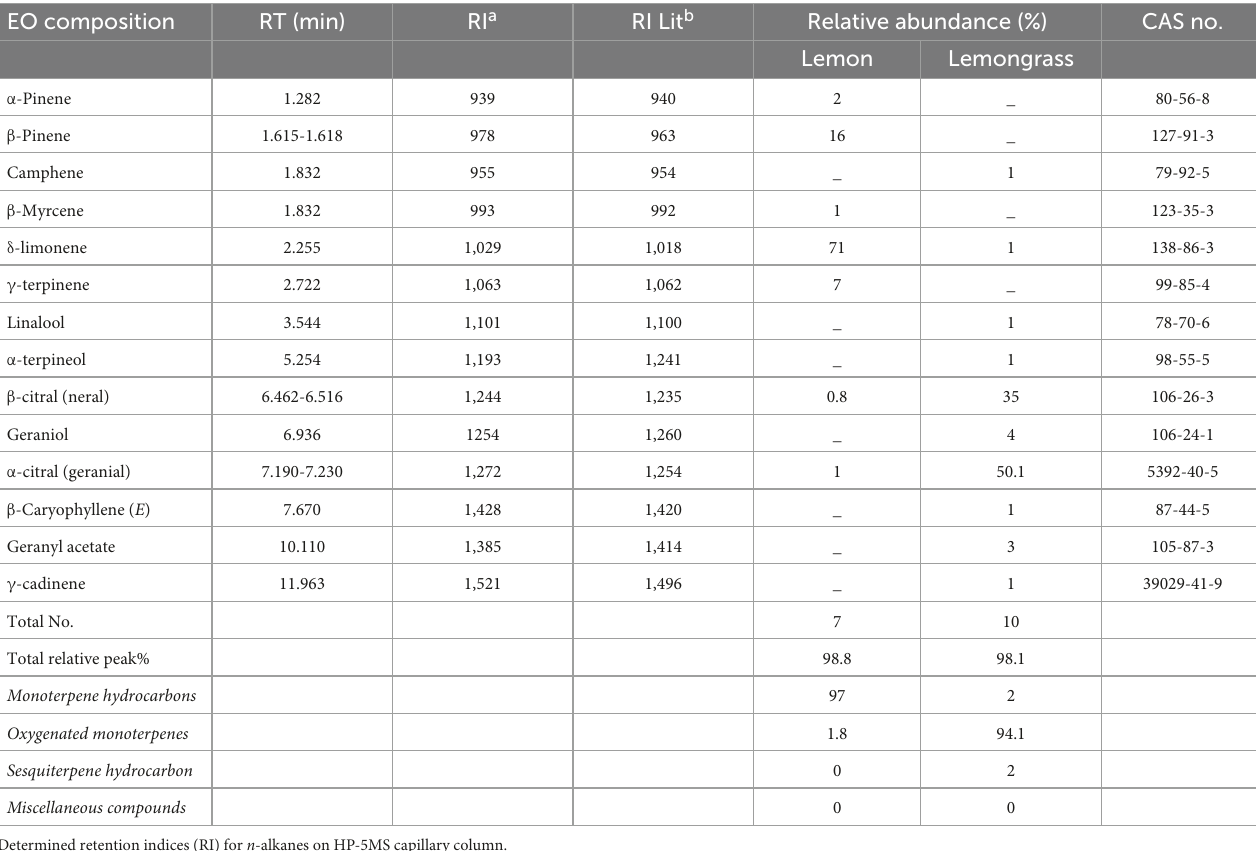
TABLE 1 Relative peaks (%) of major volatile composition of selected essential oils from GC-FID. EO composition